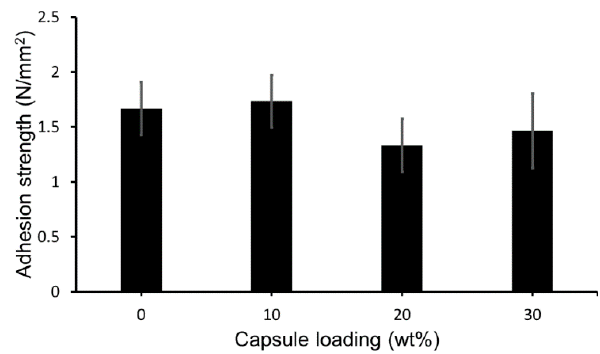
Figure 3. Adhesion strength of the control and self-healing coatings with 0 (control), 10, 20 and 30 wt % capsule loading.